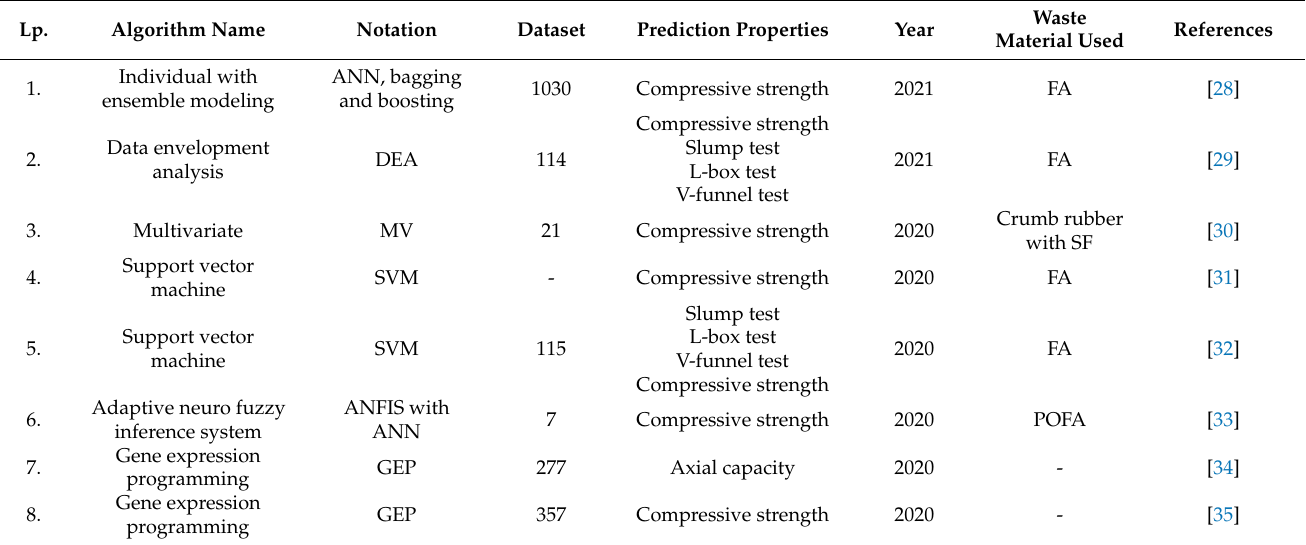
Table 1. Prediction properties with different